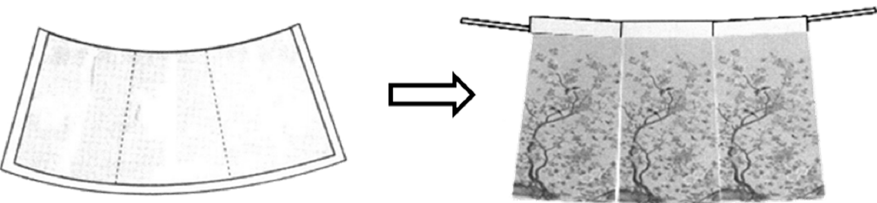
Figure 9. Design inside the panel.